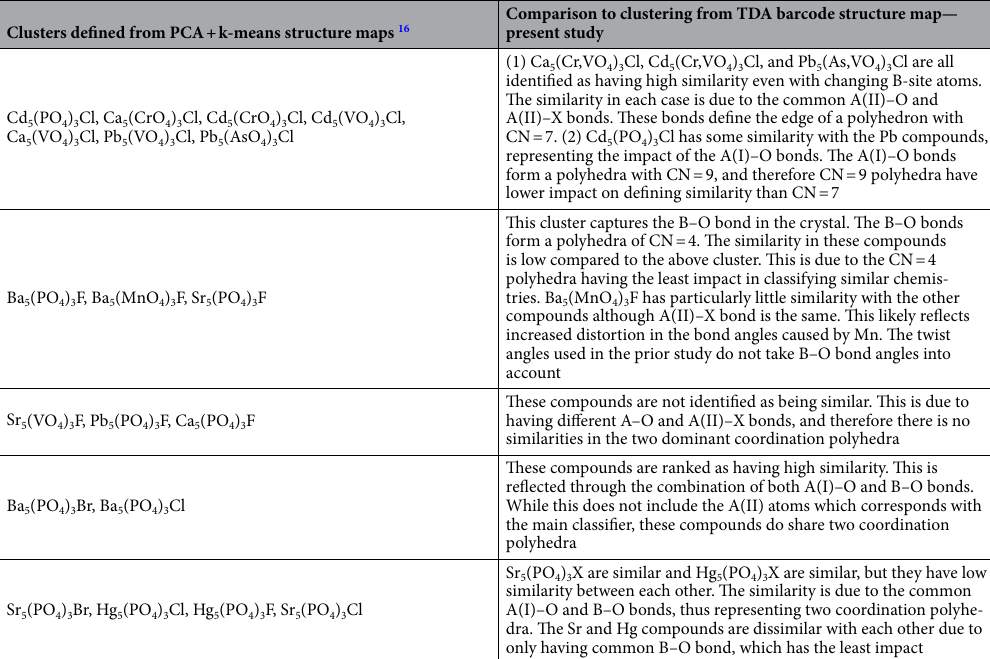
Clusters defined from PCA + k-means structure maps 16